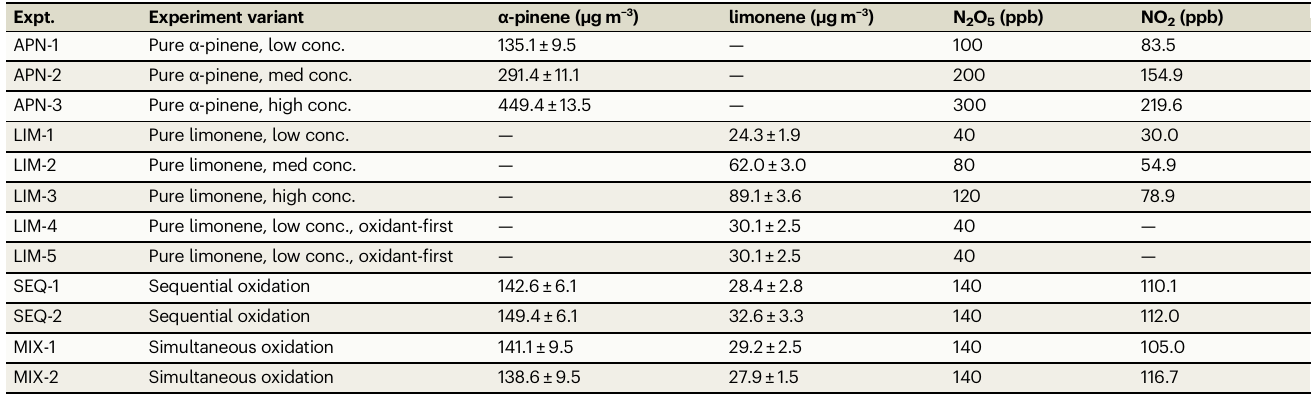
Table 1 | Summary of experimental conditions